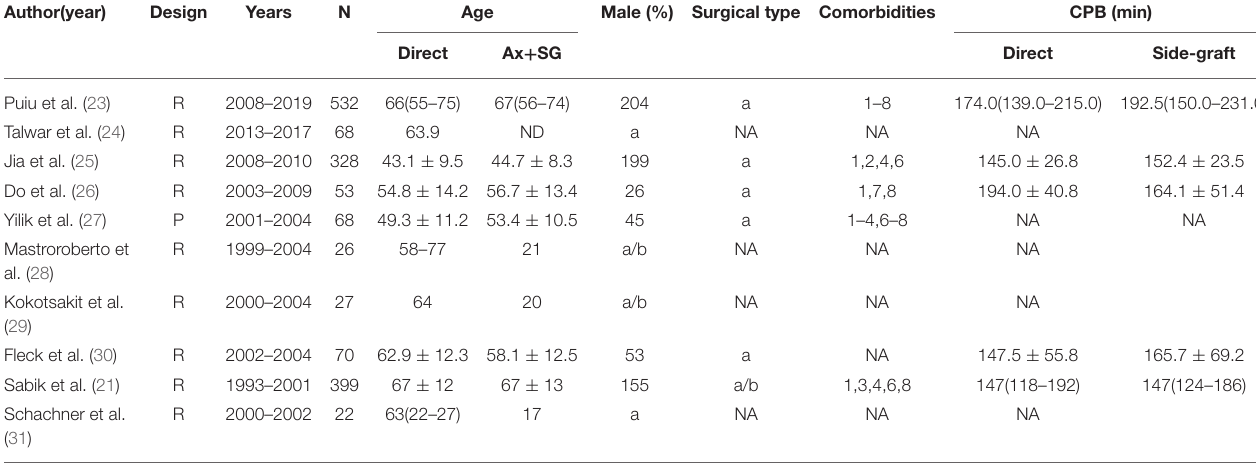
TABLE 2 | Baseline characteristics of the ten eligible